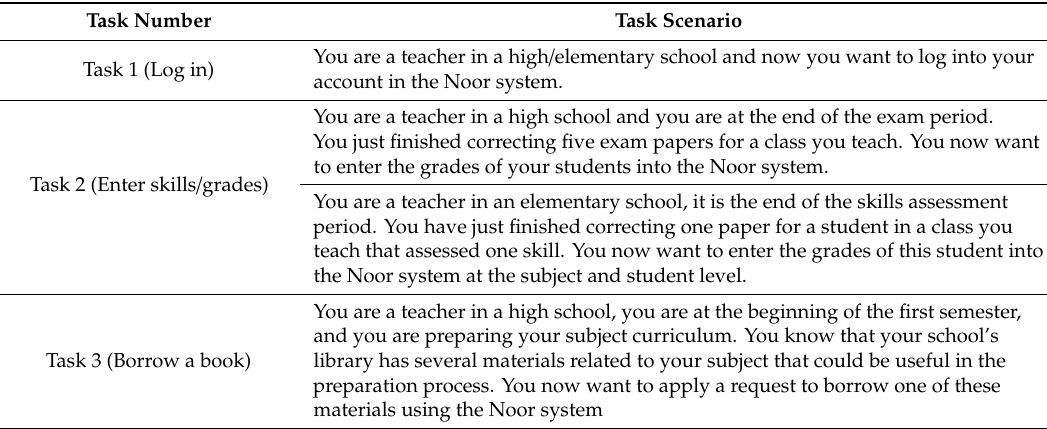
Table 4. Noor system task